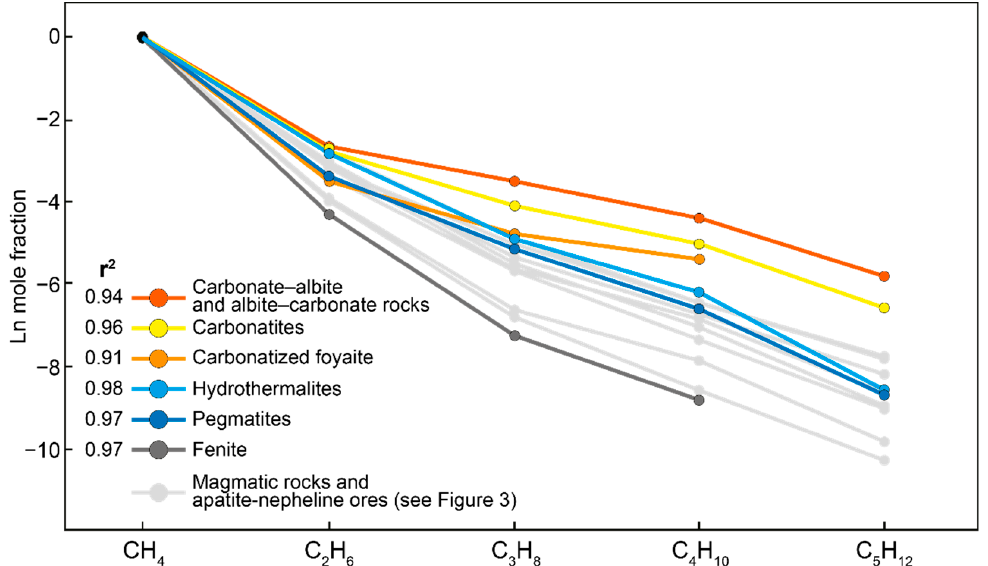
Figure 4. Median molecular weight distributions of hydrocarbon gases in the carbonatites, hydrothermalites, pegmatites, and other rocks of the Khibiny massif. r 2 —coefficients of determination to best ‐ fit lines.